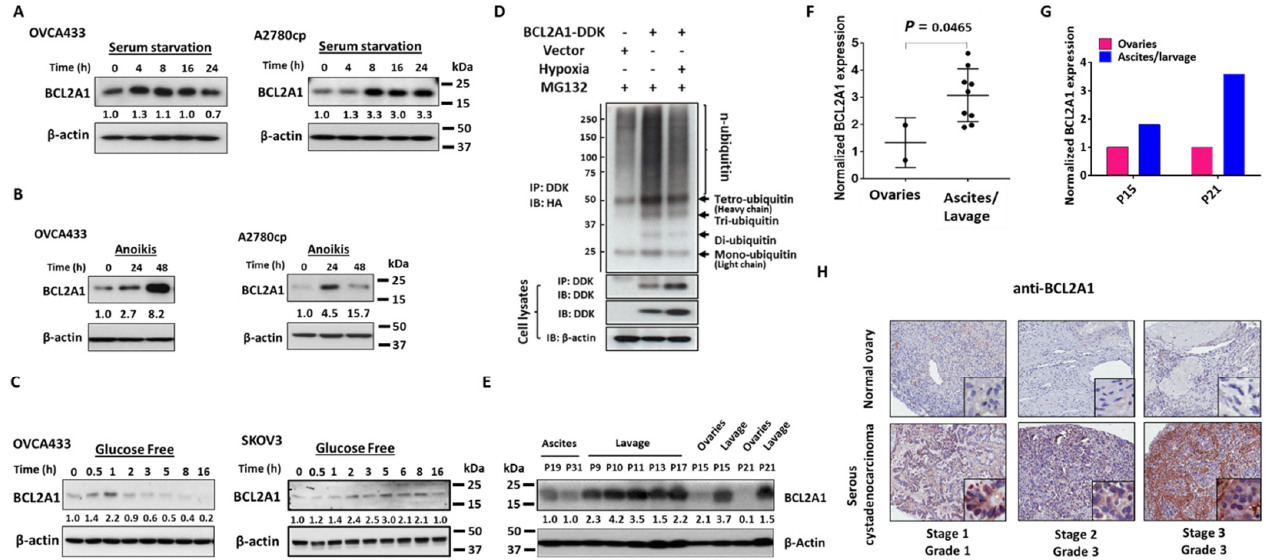
Figure 3. BCL2A1 could be induced by various physiological stresses and associated with advanced metastatic ovarian cancers. ( A ) OVCA433 and A2780cp cells were treated with DMEM containing 0% FBS for different time points (0–24 h). ( B ) OVCA433 and A2780cp cells were cultured in an ultra-low attachment 6-well plate for 24 h and 48 h. ( C ) OVCA433 and SKOV3 cells were treated with glucose-free media containing 10% dialyzed FBS for different time points (0–16 h). Western blot assay was conducted to examine the expression level of BCL2A1 for the above stressful treatments. β -actin was used as a loading control. ( D ) The pcDNA-HA(Ub)8 and pCMV6-BCL2A1-DKK plasmids were transiently transfected to OVCA433 cells. Twenty-four hours after transfection, the cells were treated with MG132 (10 μ g) and cultured in hypoxia (0.5% O 2 ) or normoxia condition for 16 h. Anti-DDK was used to pull-down ubiquitin-HA. The immunoblotting result showed that hypoxia treatment inhibited the ubiquitin level of BCL2A1 protein. ( E ) Western blot analysis of BCL2A1 in primary ovarian cancer cells isolated from primary ovarian tumors (ovaries), ascites/lavage clinical samples of ovarian cancer patients (P9–P21). β -actin was used as a loading control. ( F ) Quantification of Western blot analysis by gray intensity analysis (Image J) for BCL2A1 expression in primary ovarian cells from primary ovarian tumors (ovaries) and ascites/lavage clinical samples. The expression was normalized to that of β -actin. ( G ) Quantification of Western blot analysis by gray intensity analysis (Image J) for BCL2A1 expression in paired clinical samples (P15 and P21) of primary ovarian tumors and ascites/lavage samples. The expression of BCL2A1 was normalized to that of β -actin. ( H ) BCL2A1 expression in clinical ovarian cancers was examined by immunohistochemical (IHC) analysis using a commercial ovarian cancer tissue array (OV481, US